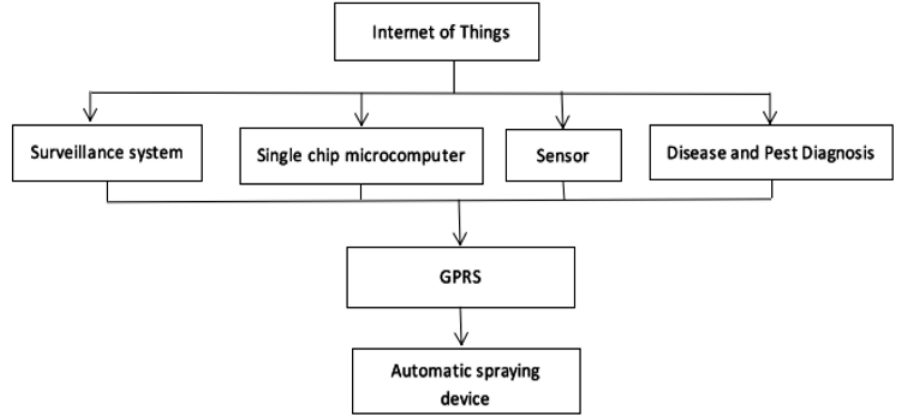
Fig. 1. Automatic spraying device based on Internet of